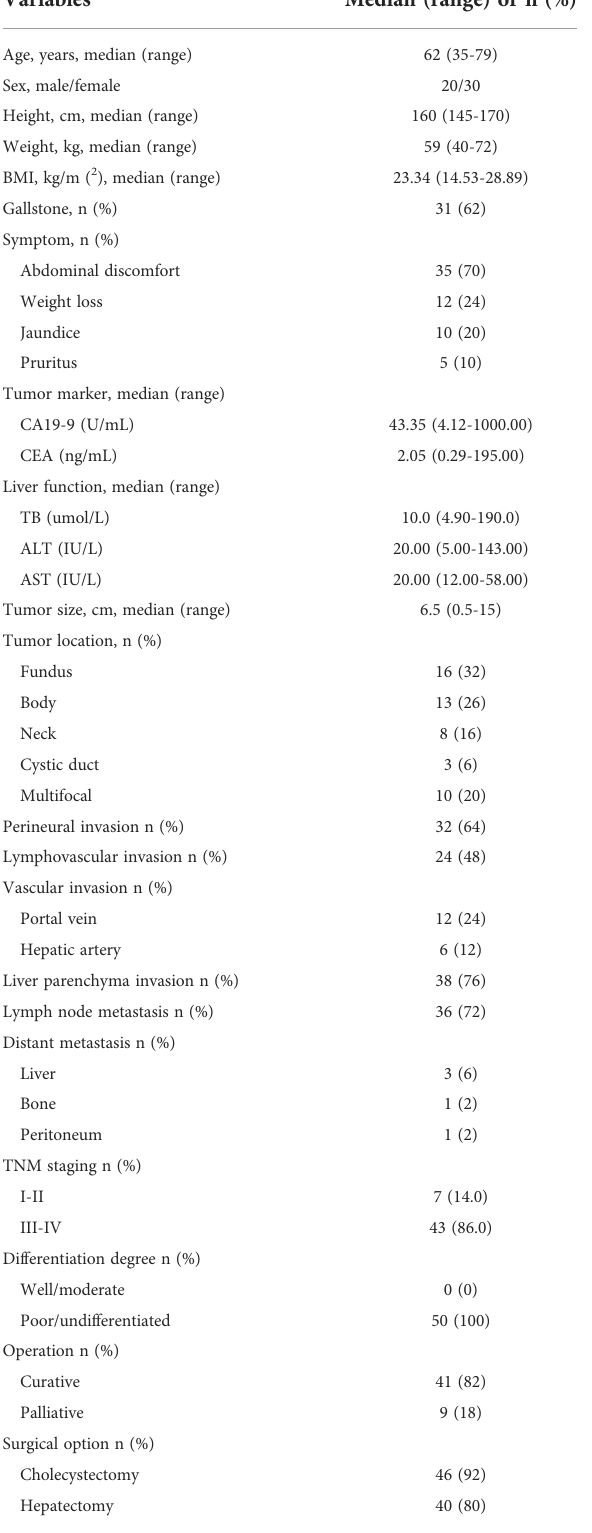
TABLE 1 Clinical and pathological characteristics of the 50 resected cases of GBSC.